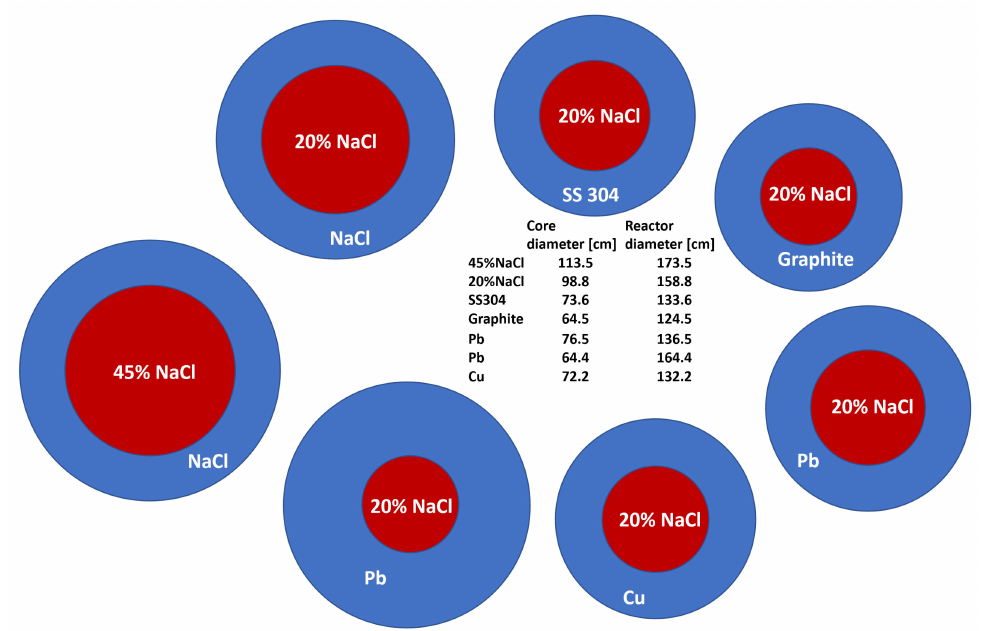
Figure 10. To-scale variation of the 2D core dimension: reflector thicknesses and resulting system dimensions required to achieve a critical configuration for a zero-power